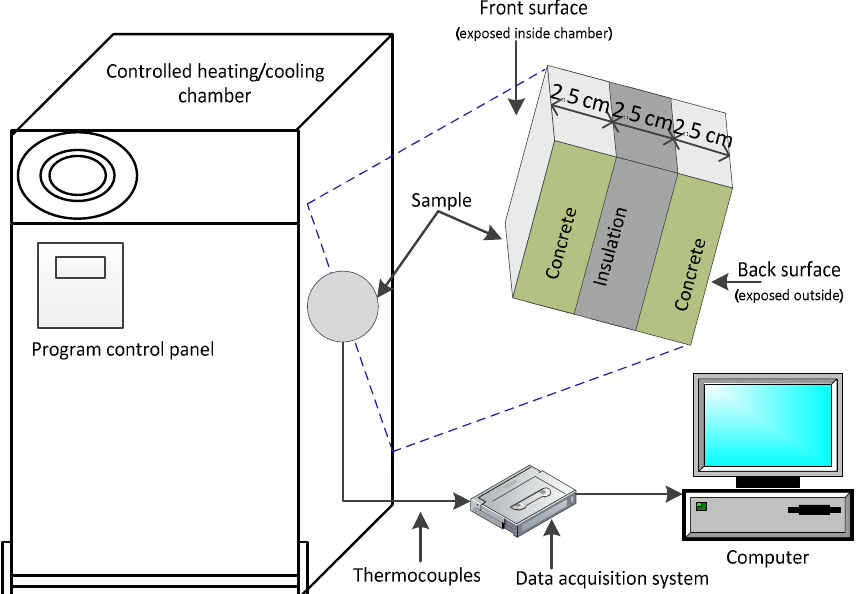
Figure 1. Schematic diagram of the experimental set up with geometry of the concrete block.